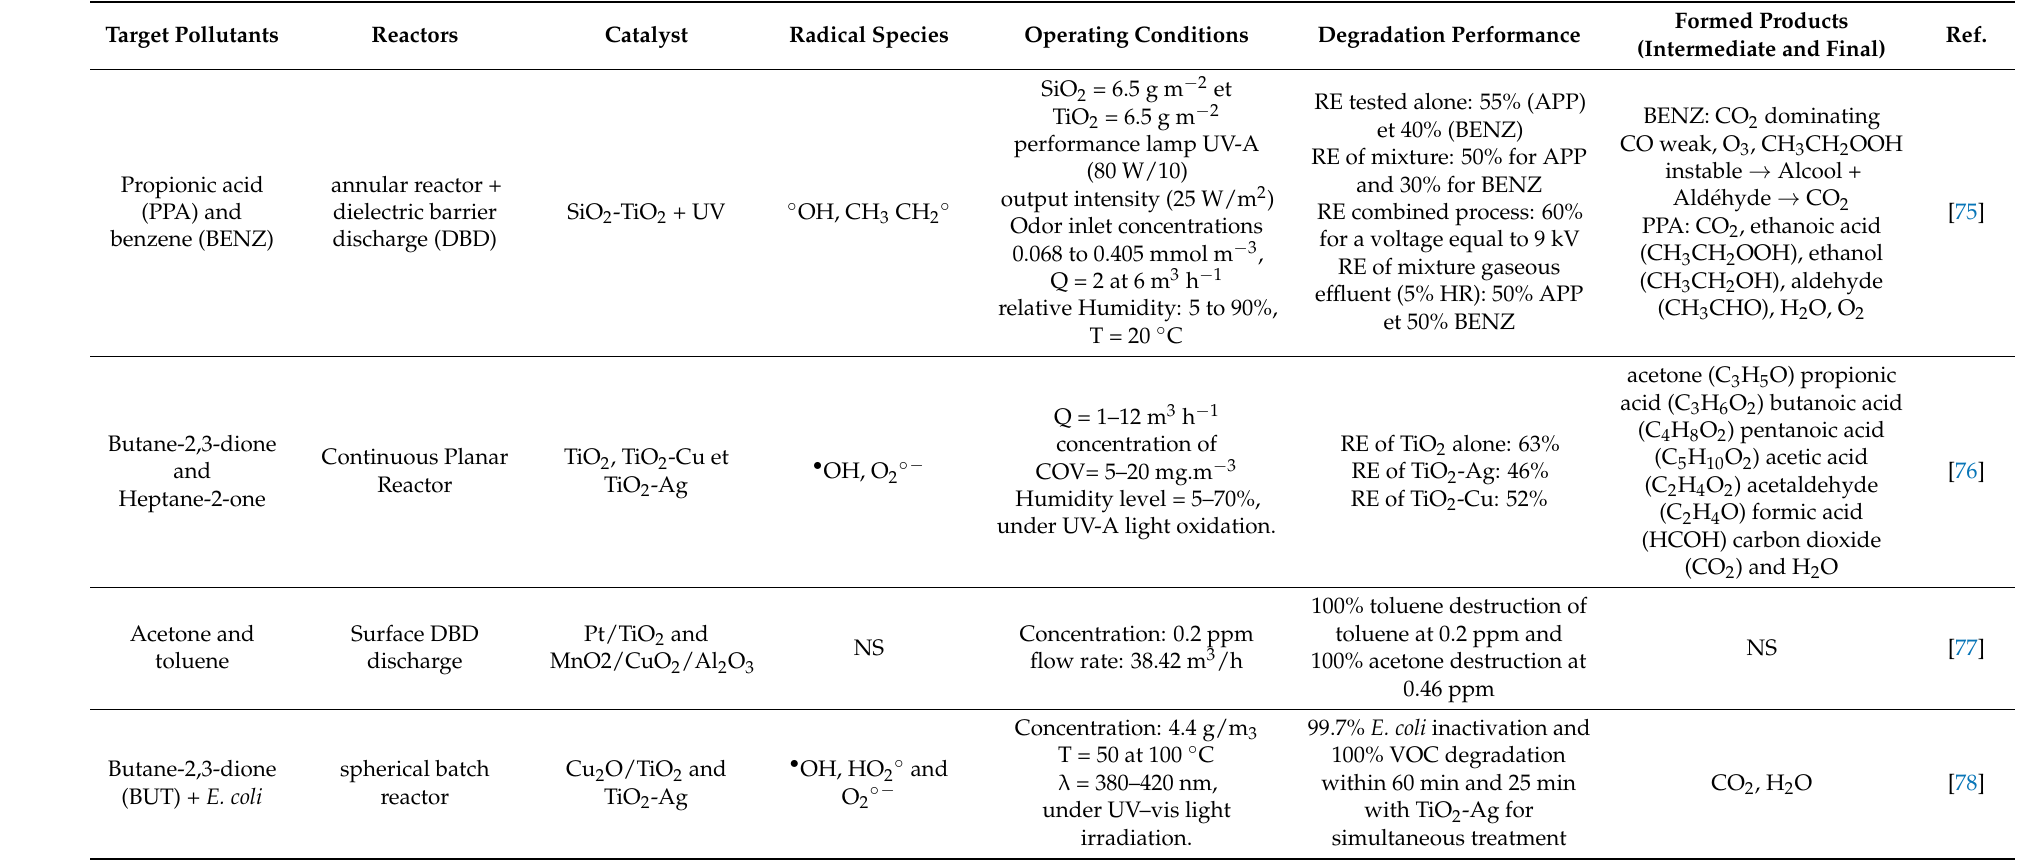
Table 1. List of some studies on using TiO 2 -metal for VOCs